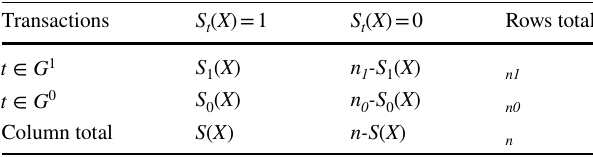
Table 3 2 × 2 Contingency table for X